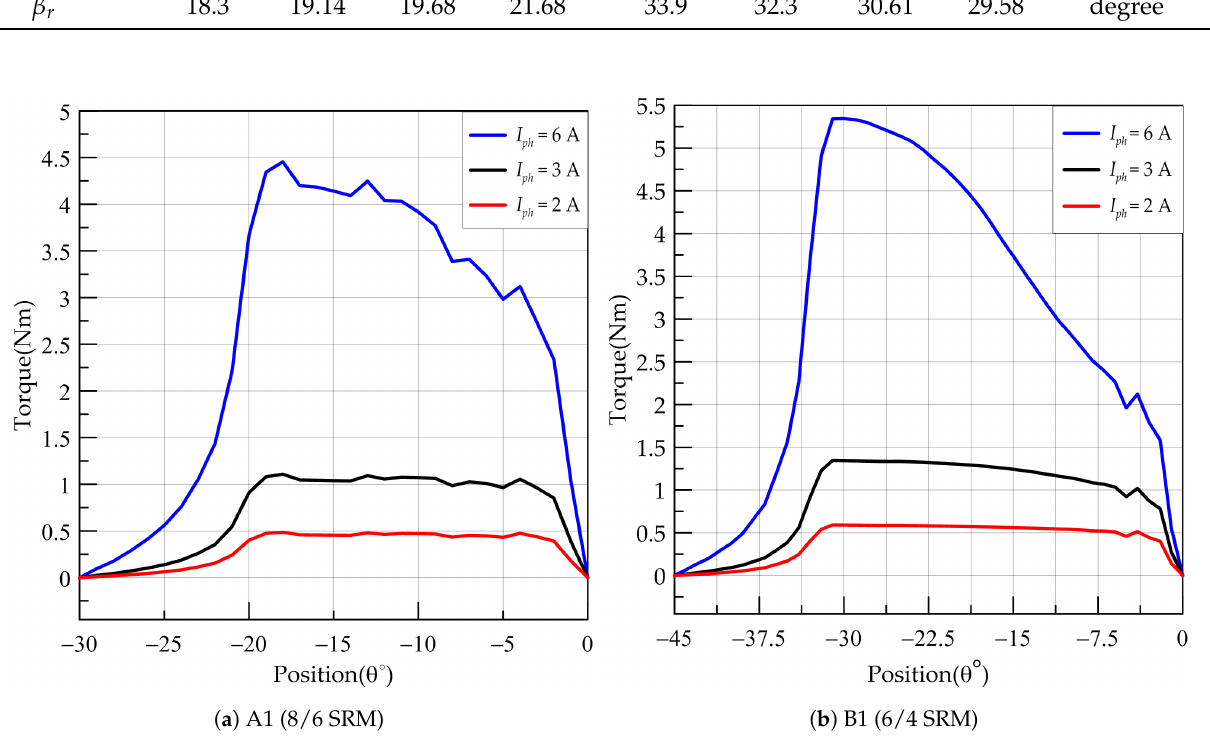
Figure 8. Developed torque of one phase for different excitation